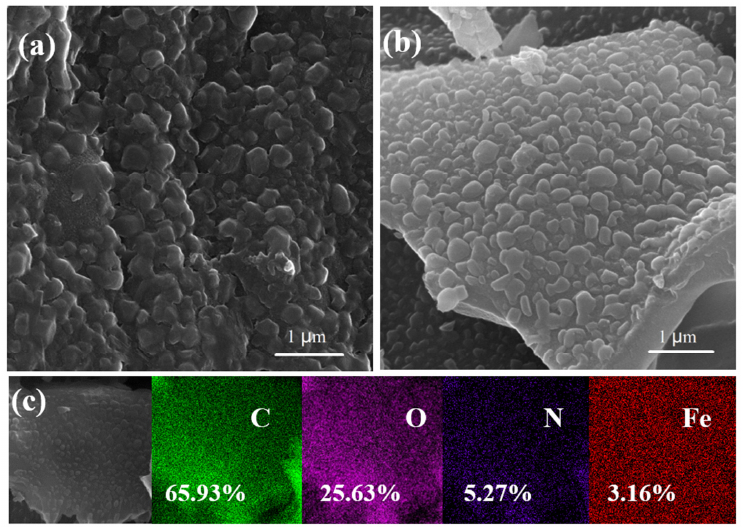
Figure 1. The SEM images of Fe–N–BC ( a ), E/Fe–N–BC ( b ), and the element mapping of E/Fe–N–BC ( c ). The XRD results (Figure 2a) show that BC and N–BC had a single peak at 25°, which can be assigned to the disorder carbon [36]. When FeNaEDTA alone was used as the precursor, the peaks at 30.24°, 35.63°, 43.28°, 53.73°, 57.21°, and 62.93° in Fe–N–C corresponded to (220), (311), (400), (422), (511), and (440) planes of γ –Fe 2 O 3 (PDF–39– 1346), respectively [37,38], indicating the formation of γ –Fe 2 O 3 . However, after the addition of biomass and EDTA, no crystalline peak could be observed on Fe–N–BC and E/Fe–N–BC, which may be attributed to the coating of deposition carbon. To explore the transformation of iron species during pyrolysis, XPS analyses were adopted to investigate the surface elements contents and their chemical valence state of Fe–N–BC and E/Fe–N–BC. Their full survey spectra and elements contents are shown in Figure S3 and Table S2. It can be seen that the C and Fe contents in Fe–N–BC were 83.74% and 0.56%, respectively, indicating the successful loading of Fe on biochar. When EDTA was introduced during the synthesis, the C content (85.37%) in E/Fe–N–BC slightly enlarged with a gradual reduction of Fe (0.45%). This may have been caused by the formation of C from EDTA during pyrolysis. As shown in Figure S4, two obvious peaks located at 711.2 eV and 724.8 eV are assigned to Fe 2P 3/2 and Fe 2P 1/2 , respectively. Additionally, two satellite signals at 718.8 eV and 732.6 eV are attributed to the typical characteristics of γ –Fe 2 O 3 [25,39], which is consistent with the XRD results. This indicated that the iron species were presented mainly in the Fe (III) state for Fe–N–C. As shown in Figure 2b, due to the appearance of Fe (II) [25,37], the signal peaks of Fe 2P 3/2 and Fe 2P 1/2 for Fe–N–BC shifted to lower binding energies (711.0 eV and 724.6 eV). Moreover, a similar phenomenon was observed on E/Fe–N–BC. These results indicat that a portion of Fe (III) ions in Fe–N–BC and E/Fe–N–BC were converted into Fe (II) to generate mixed γ – Fe 2 O 3 − x under low–temperature (280 °C) pyrolysis, which may be ascribed to the fact that FeNaEDTA, as an organic compound, can generate nanoscale Fe (III) precursors through a sol–gel reaction to decrease the reduction temperature. It is found that the proportions